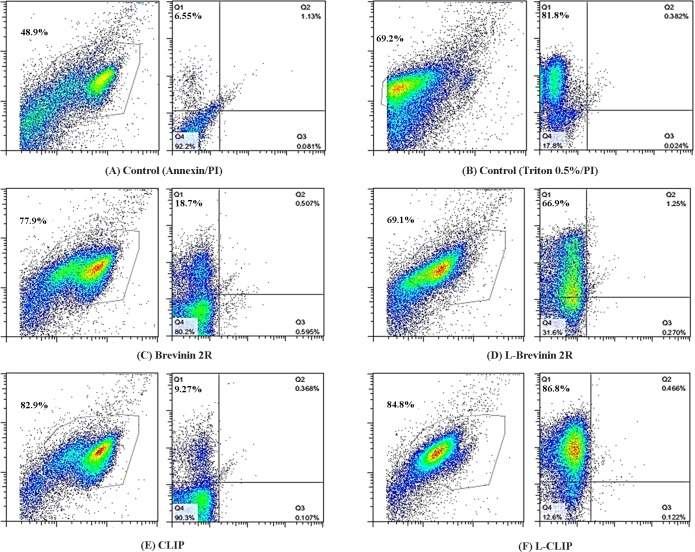
Flow cytometry results of L. major promastigotes exposed to different peptides. Effective peptides affected L. major through necrosis. No signs of apoptosis event were detected. (A) Untreated parasite stained with Annexin/PI, (B) Parasite treated with 0.5% Triton x-100 as positive control for PI. (C) Brevinin 2R, (D) L- Brevinin 2R, (E) CLIP and (F) L- CLIP treated parasite. In each pair of graphs, the left represents SSC vs FSC and the right graph indicates PI vs Annexin value.